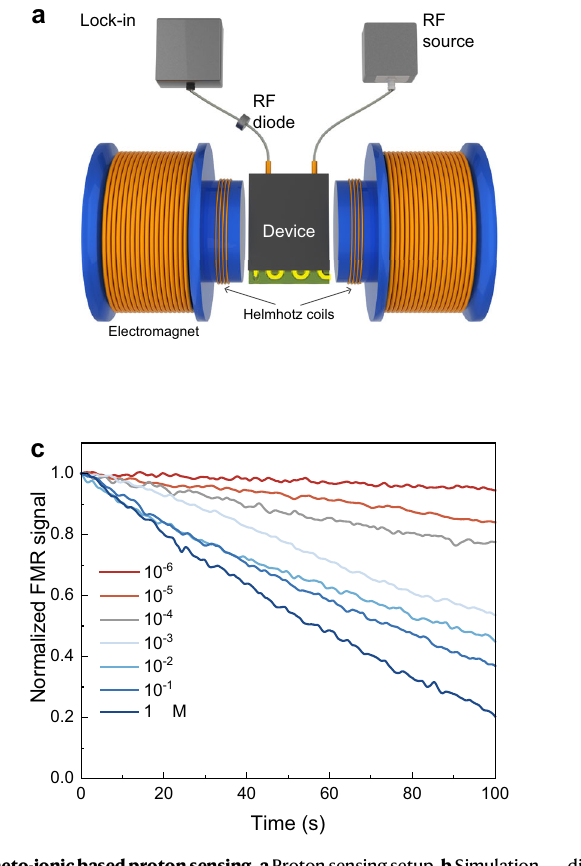
different proton concentrations. A constant biasvoltage of − 0.7V isapplied to the device during the measurement. d Proton concentration-dependent normalized FMR signal at 100s. Source data are provided as a Source Data fi